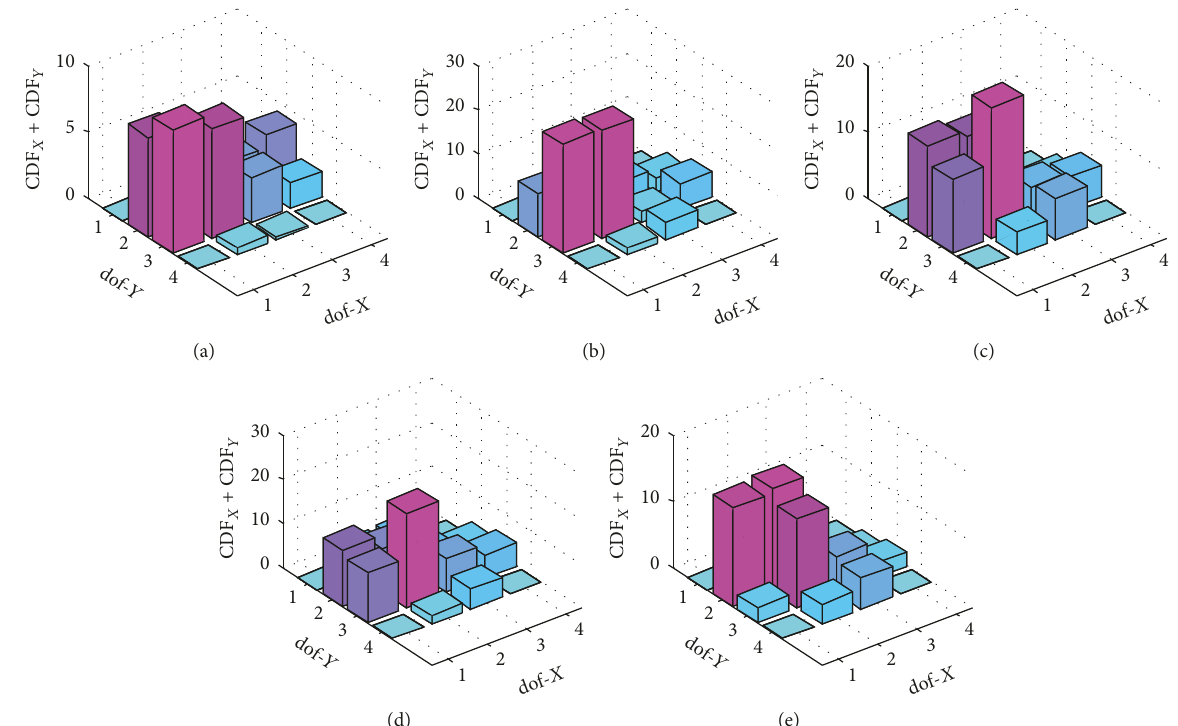
Figure 13: CDF calculated the modal data obtained from SSI Method. (a) DS0 versus DS1, (b) DS0 versus DS2, (c) DS0 versus DS3, (d) DS0 versus DS4, and (e) DS0 versus DS5.